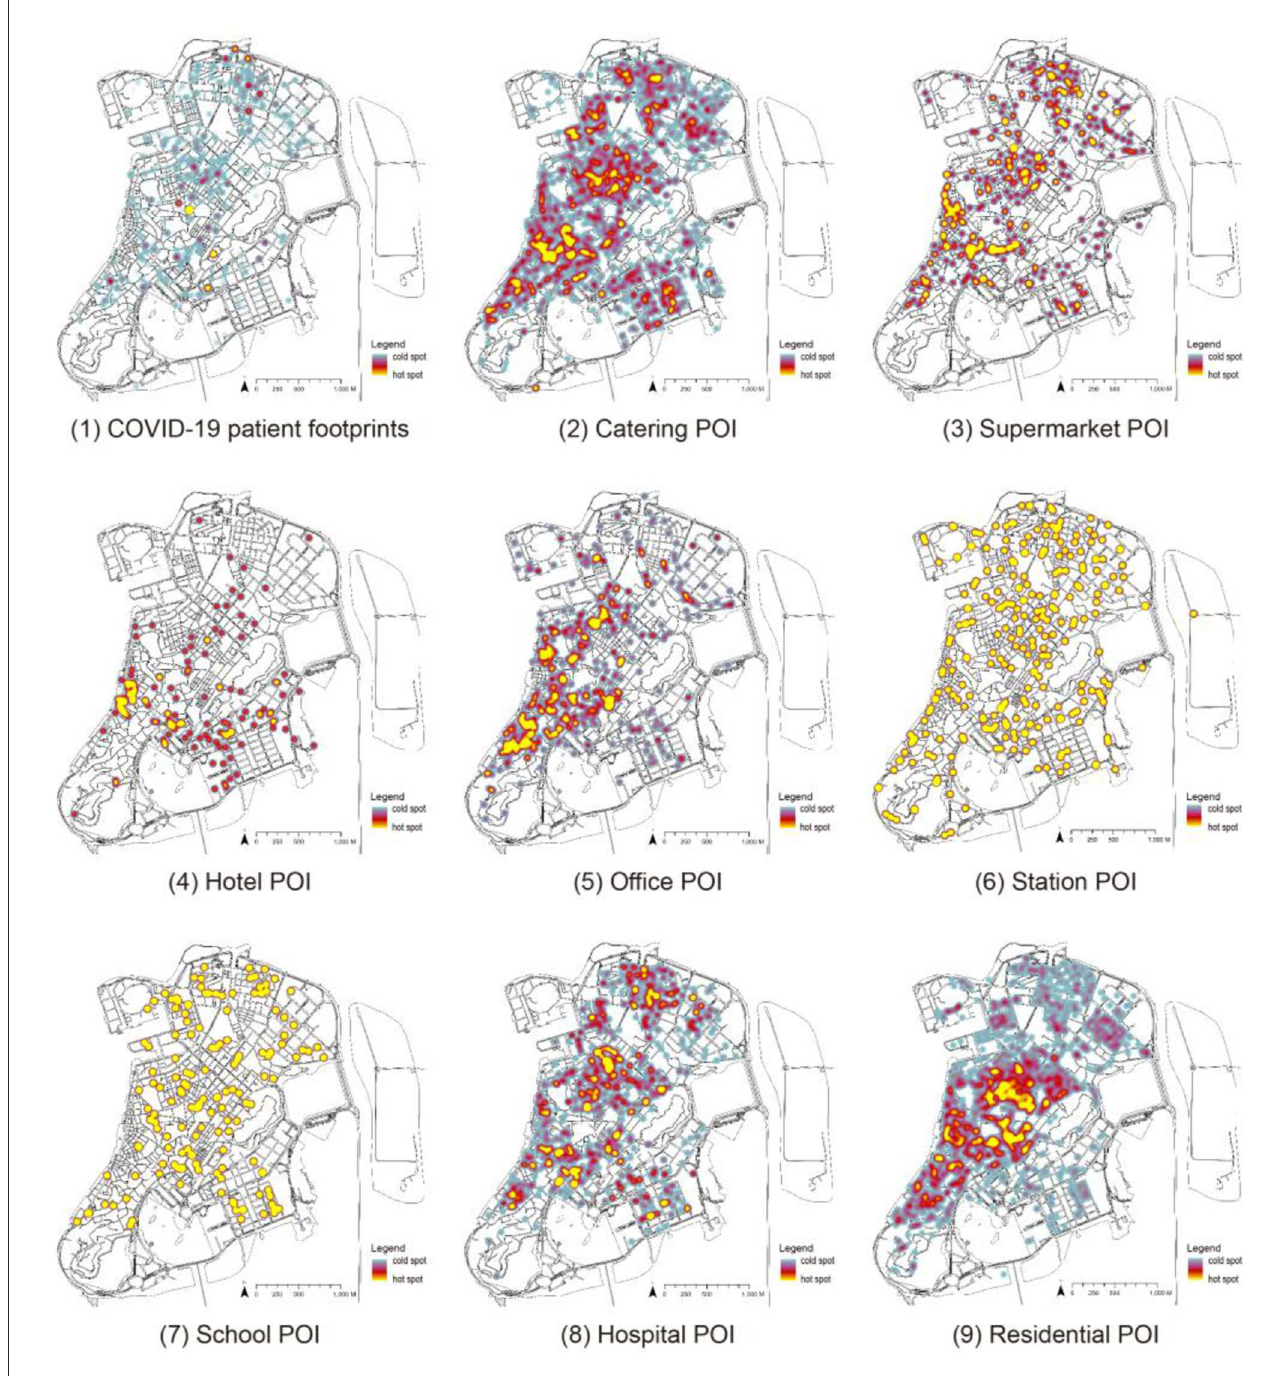
FIGURE5 COVID-19 epidemic footprint and heat map of different types of POIs.